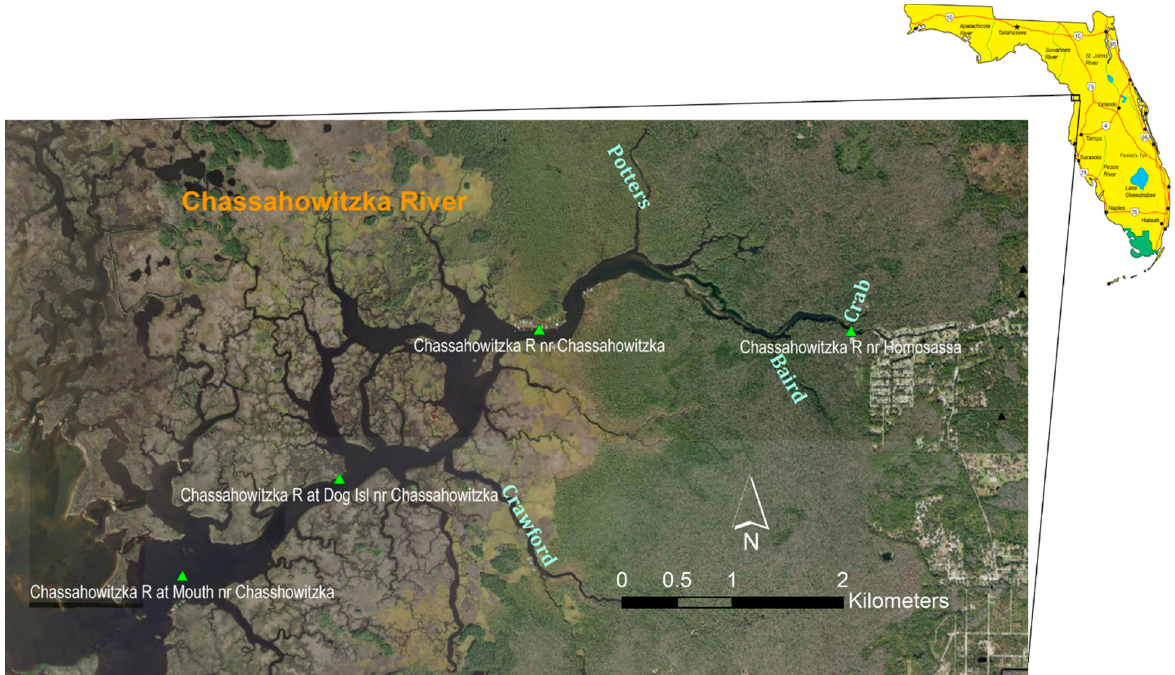
Figure 1. Aerial view of the Chassahowitzka River on the Gulf coast of Florida. Solid green triangles are locations of the USGS stations where real-time data of water elevation, salinity, and temperature were measured.